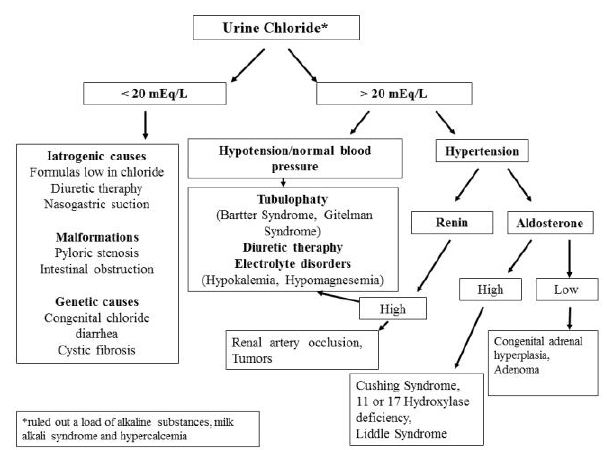
Figure 1: Diagnostic algorithm of metabolic alkalosis based on urine